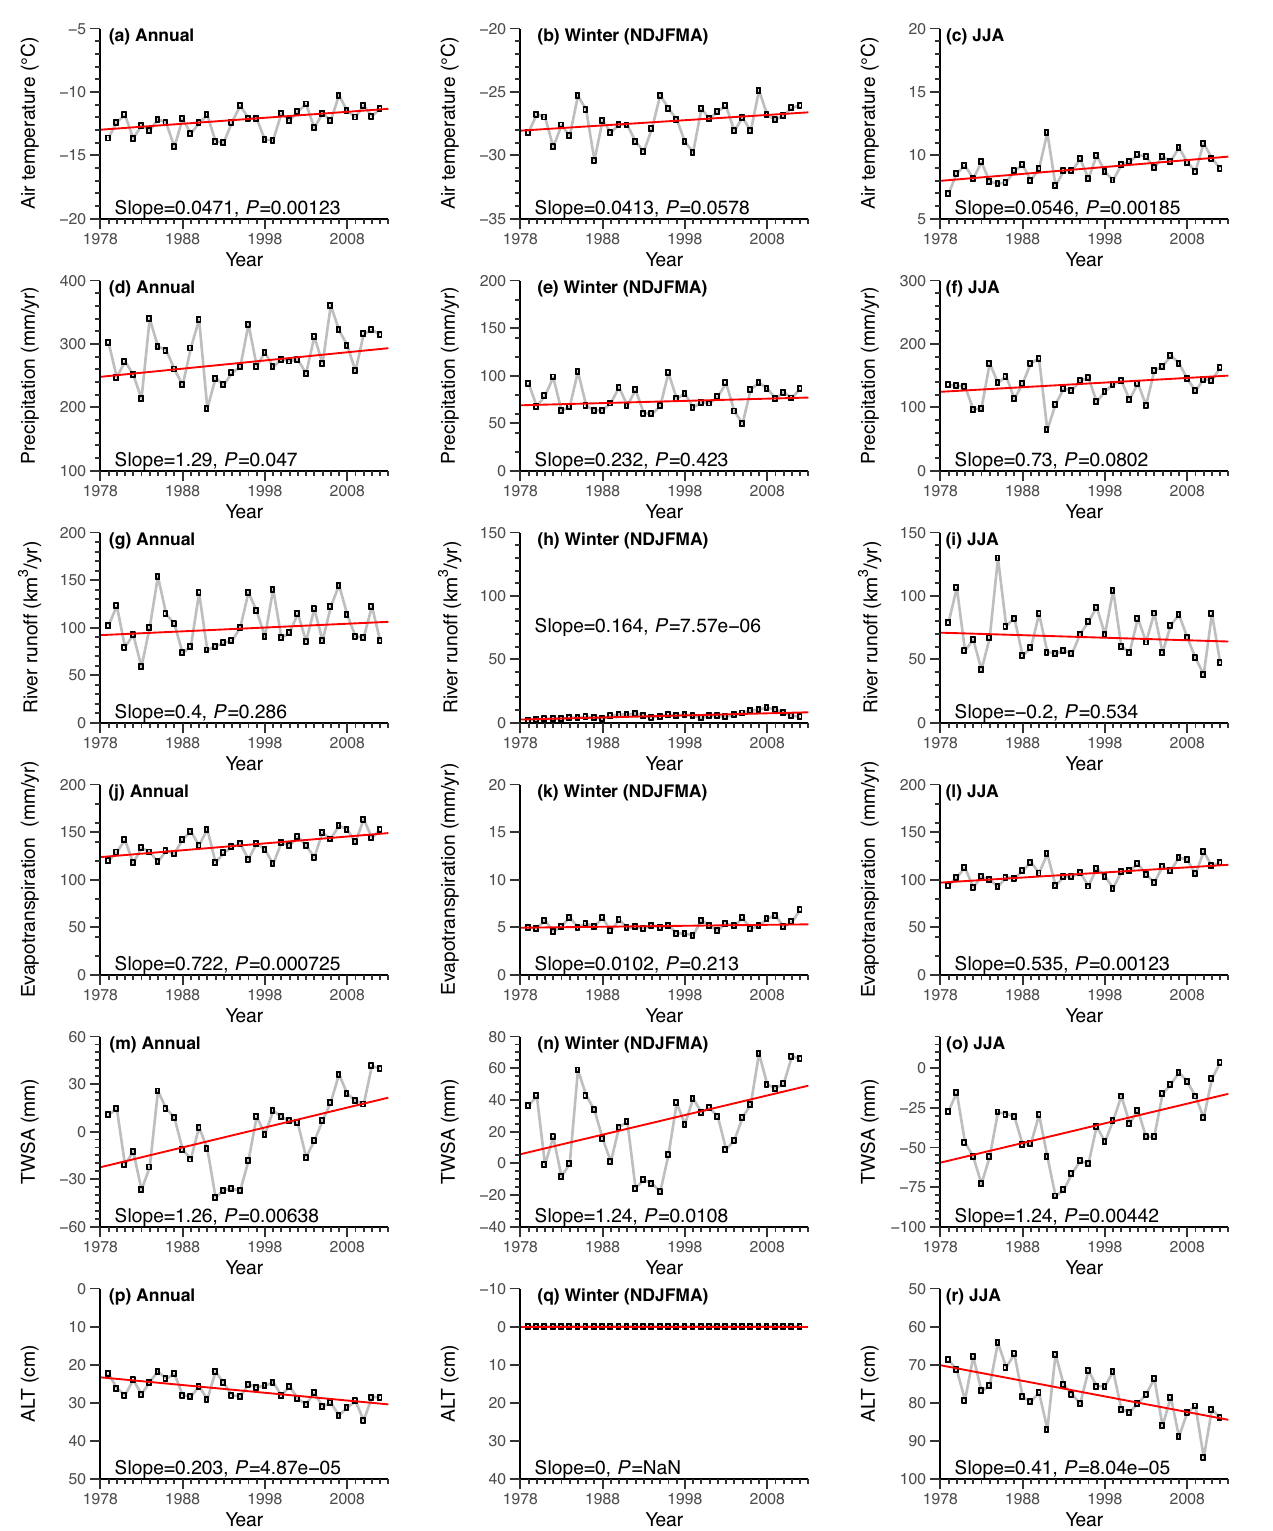
Figure 11. Interannual variations in basin-averaged hydrometeorological factors annually and during winter and summer: ( a – c ) Denote the mean annual, winter, and summer air temperature, respectively; ( d – f ) Denote the mean annual, winter, and summer precipitation, respectively; ( g – i ) Denote the mean annual, winter, and summer river discharge, respectively; ( j – l ) Denote the mean annual, winter, and summer evapotranspiration, respectively; ( m – o ) Denote the mean annual, winter, and summer terrestrial water storage anomaly (TWSA), respectively; ( p – r ) Denote the mean annual, winter, and summer active layer thickness (ALT), respectively. Here, ( j – r ) are CHANGE-based